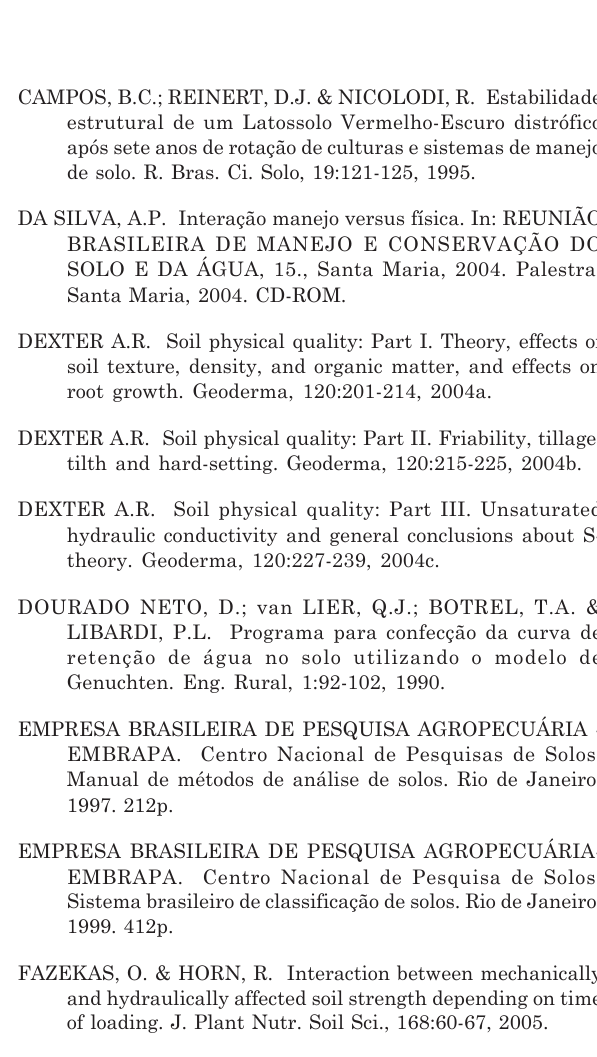
Figura 6. Comportamento da água disponível às plantas (kg kg -1 ) em função do parâmetro S (a) e comportamento da pressão de pré-consolidação (kPa) em função do parâmetro S (b). (* o modelo ajustado é significativo a p < 0,01 pelo teste